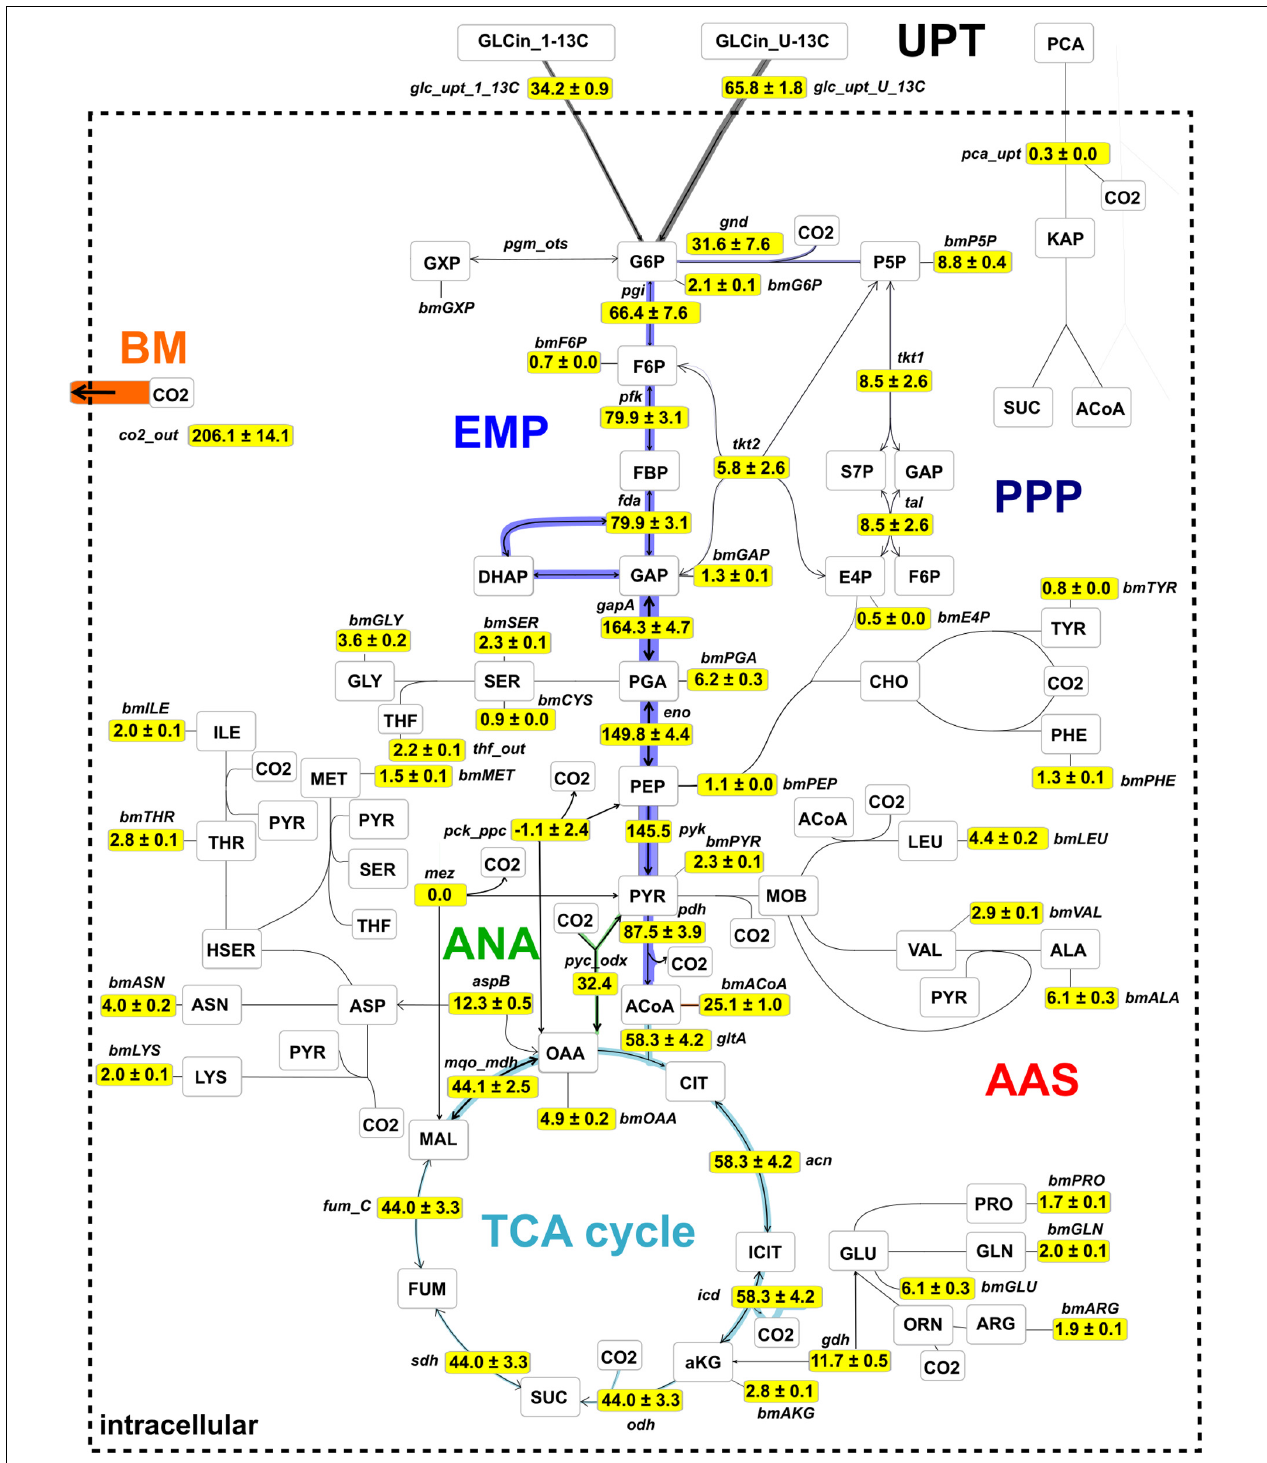
FIGURE 8 | Metabolic flux map for C. glutamicum WT cultivated under continuous conditions at growth rate µ = 0.41 h - 1 using glucose as main carbon source. Fluxes were estimated using isotopic stationary 13 C-MFA with a data set generated in a CLE with 33% (1- 13 C)- and 67% (U- 13 C)- D -glucose. Shown are net flux values, normalized to glucose uptake rate ( v GLC = 4,086 µ mol g CDW - 1 h - 1 ), together with their standard deviations. The complete absolute and relative flux distributions are provided in the Supplementary Table 2 . The flux map is drawn using the network editor and visualization tool Omix (Omix Visualization GmbH, Lennestadt, Germany, www.omix-visualization.com). UPT, uptake; PPP, pentose-phosphate pathway; ANA, anaplerotic section; BM, biomass; EMP, Embden–Meyerhof–Parnas; AAS, amino acid synthesis; TCA, tricarboxylic acid.